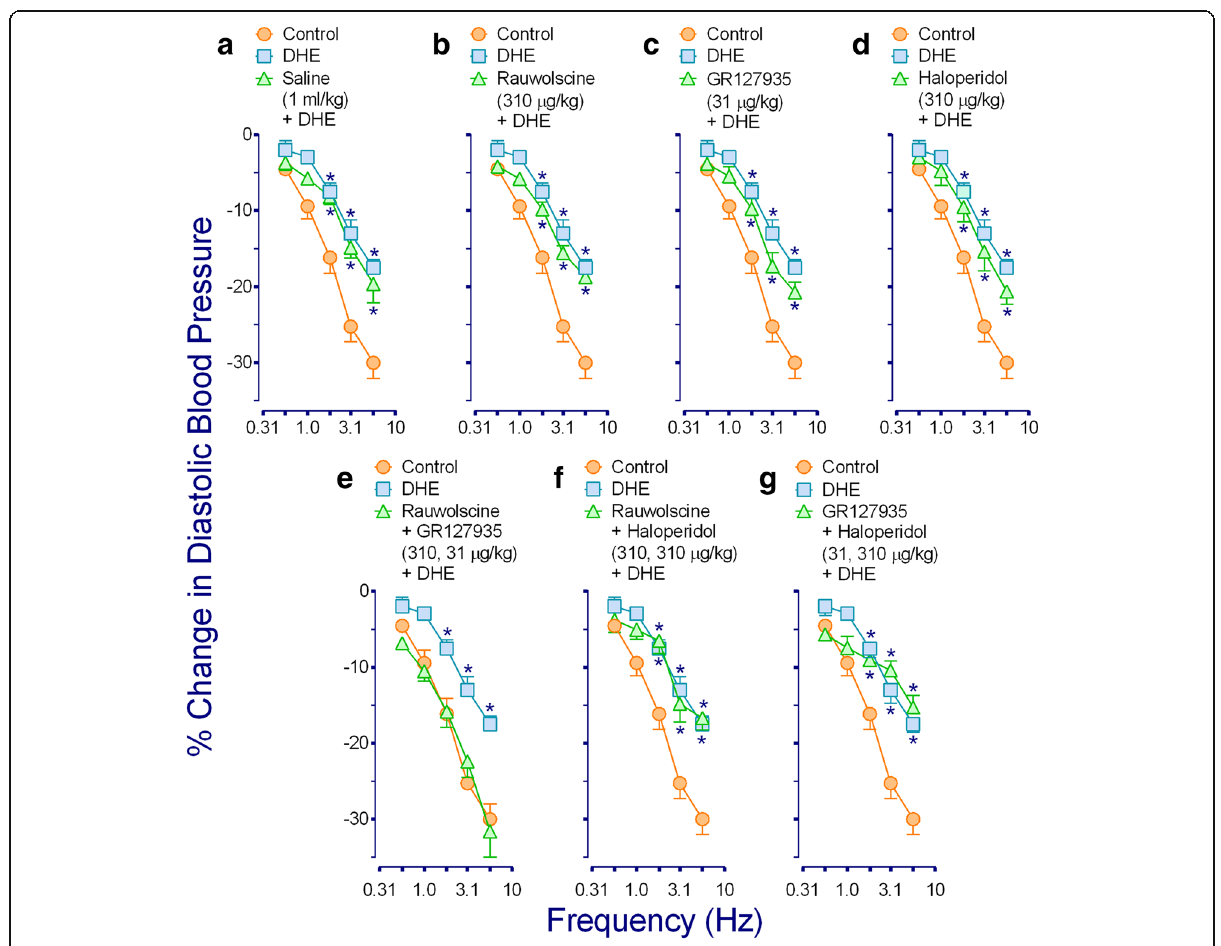
Fig. 2 Effect of i.v. bolus injections of: ( a ) saline (1 ml/kg); ( b ) rauwolscine (310 μ g/kg); ( c ) GR127935 (31 μ g/kg); or ( d ) haloperidol (310 μ g/kg) given separately, as well as the combinations ( e ) rauwolscine plus GR127935 (310 and 31 μ g/kg, respectively); ( f ) rauwolscine plus haloperidol (310 μ g/kg each); or ( g ) GR127935 plus haloperidol (31 and 310 μ g/kg, respectively) on the inhibition induced by dihydroergotamine (DHE; 3.1 μ g/kg·min; □ ) of the electrically-induced vasodepressor responses. The control responses ( ○ ) represent that of animals receiving an i.v. continuous infusion of methoxamine (20 μ g/kg·min) which is shown for comparison. * Significantly different responses ( P < 0.05) vs.